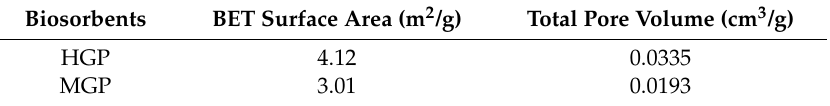
Table 1. BET surface areas and total pore volumes of the biosorbents